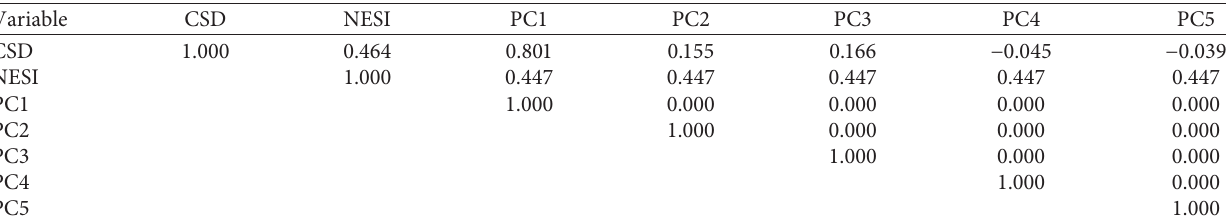
Figure 10: Residuals analysis (regression Table 4): (a) NLP SLM residuals Moran scatterplot; (b) NLP SLM predicted quantile map (source: authors’ Table 5: Pearson’s correlation test (source: authors’ elaboration).